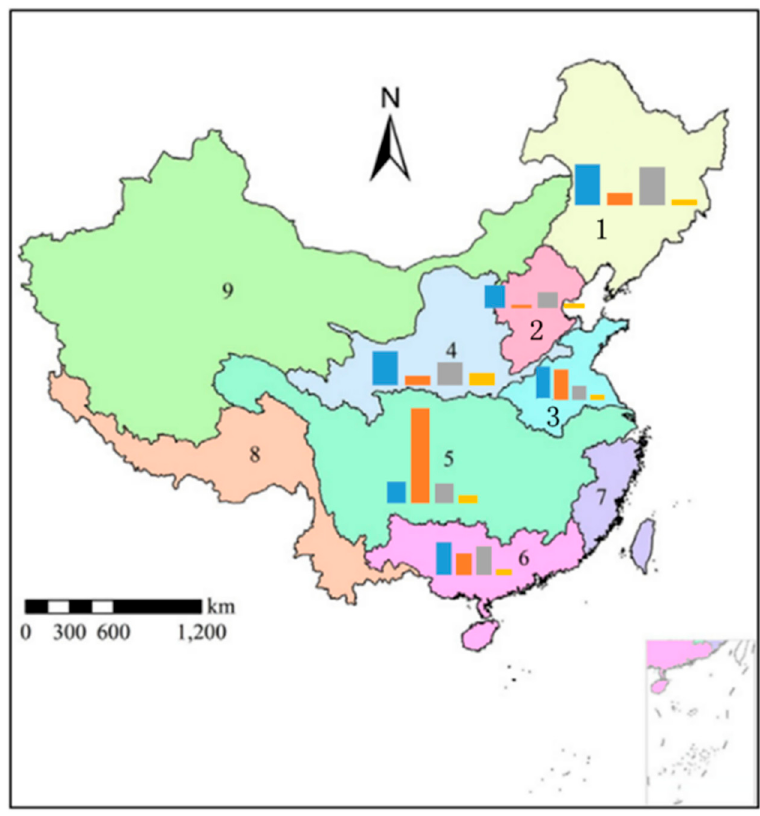
Figure 4. Nine major water basins in China. 1 = Songhua and Liao River Basin; 2 = Hai River Basin; 3 = Huai River Basin; 4 = Yellow River Basin; 5 = Yangtze River Basin; 6 = Pearl River Basin; 7 = Southeast River Basin; 8 = Southeast River Basin; 9 = Northwest River Basin. The completion percentages of different modules are shown as a histogram (blue: water consumption management (WCM module); red: water quality monitoring and management (WQMM module); grey: minimum discharge flow management (MDFM module); yellow: water dispatch management (WDM module)).